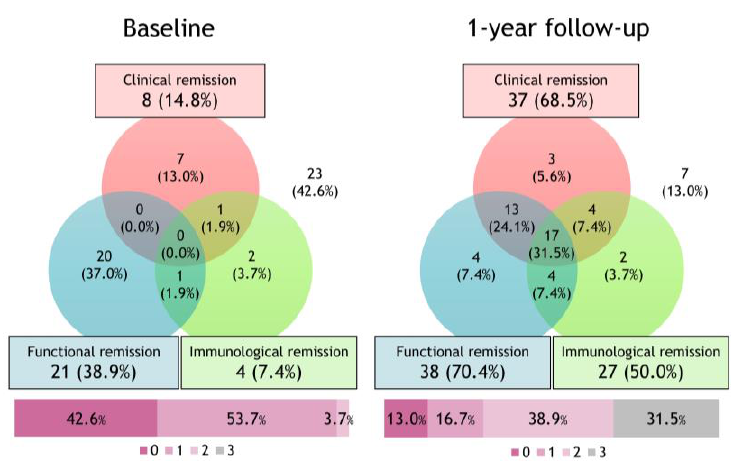
Figure 2. Changes in deep remission subtypes after initiating biologics. The Venn diagram and percentage of patients achieving the three components of deep remission before and after the initiation of biologics. With the initiation of biologics, the proportion of patients in deep remission increased from 0.0% to